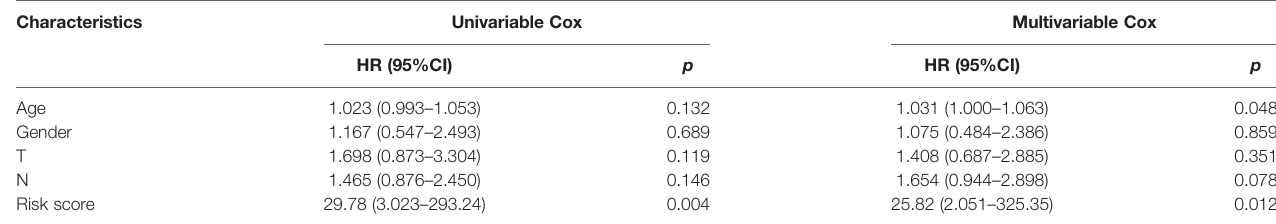
TABLE 5 | Cox regression analyses of clinical characteristics and survival in GSE84426.